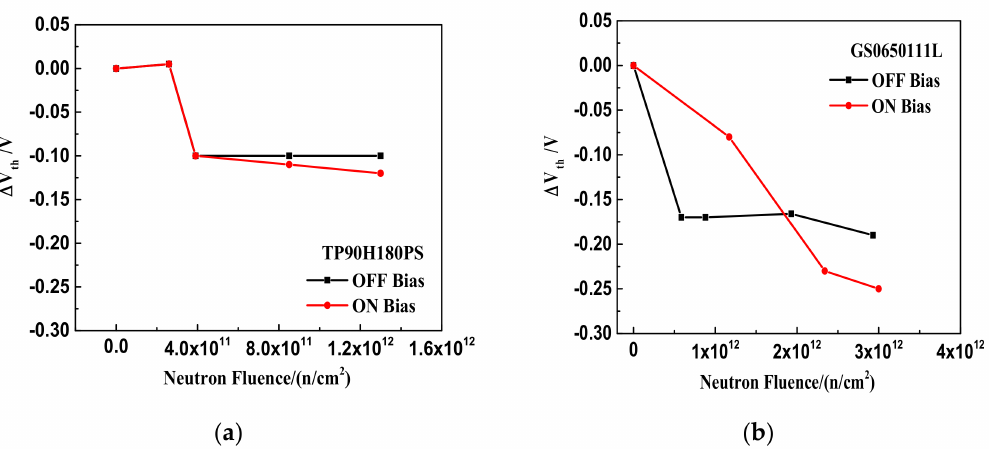
Figure 4. The relationship between the threshold voltage shifts of the device and the neutron irradiation under the on-state and off-state: ( a ) TP90H180PS and ( b )